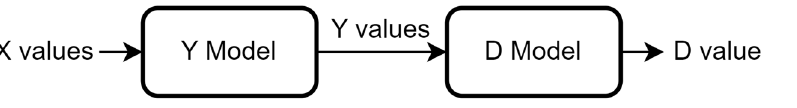
Figure 4. General working of the proposed parameter optimization methodology for the MEMS accelerometer. It is based on calculating the desirability (D) value for optimization using a cascade of two Deep Neural Networks (i.e., Y model and D model). X values correspond to (x 1 , x 2 , …, x 8 ); Y values correspond to (y 1 , y 2 , …, y 5 ); and D value refers to the desirability value.